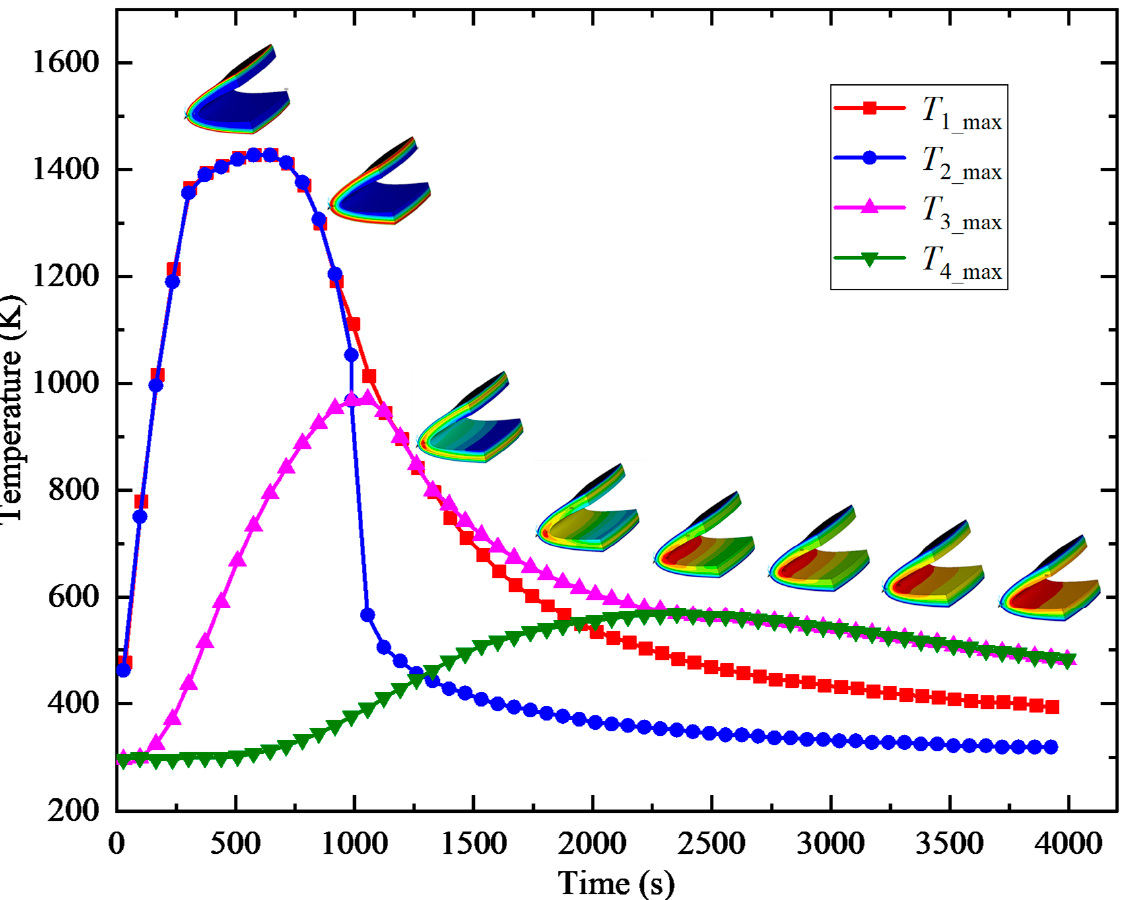
Figure 8. Maximum temperature evolution of each layer and the inner surface. (1) The internal heat transfer characteristics of each layer are different due to the differences of the material properties. For example, the maximum temperature of the C/C panel rises much faster than that of either HTTI or MTTI for the higher heat